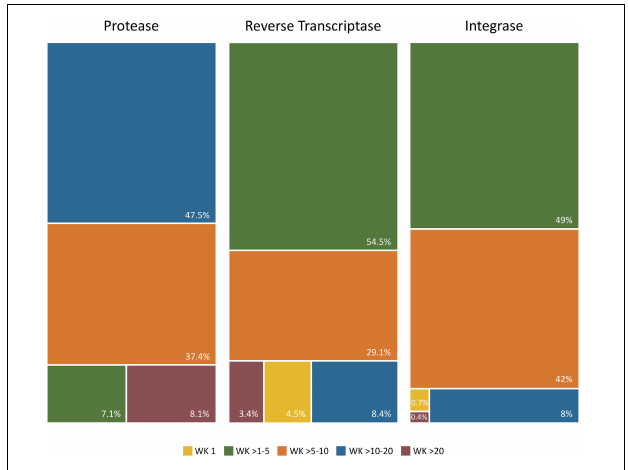
FIGURE 8 | Proportion of Wu–Kabat variability coefficient values in PR, RT, and IN residues. Each box represents the proportion of residues within each protein that present a Wu–Kabat coefficient value within the range indicated beneath the figure and colored accordingly. Protease (99 aa), reverse transcriptase (440 aa), integrase (288 aa). WK, WK variability